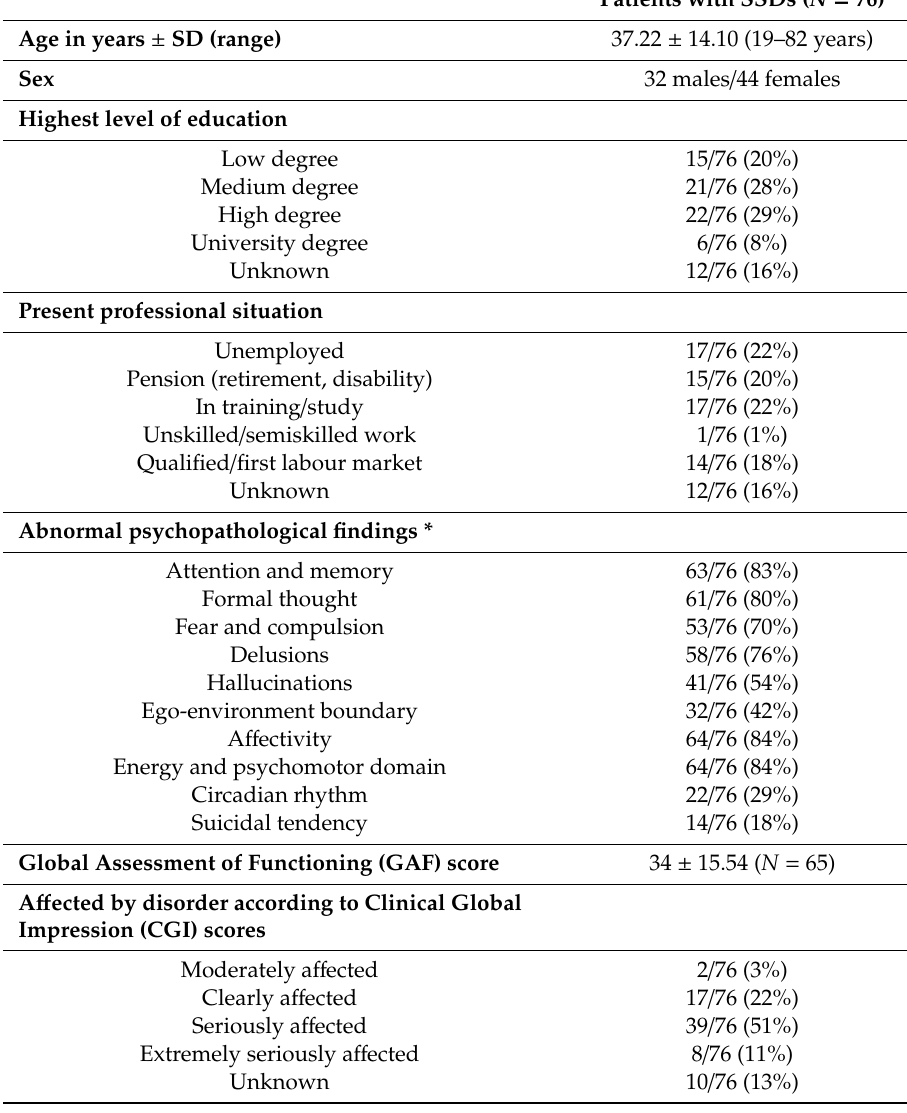
Table 2. Sociodemographic and psychopathological findings in patients with schizophrenia spectrum disorders (SSDs). * Following the criteria of the German “Arbeitsgemeinschaft für Methodik und Dokumentation in der Psychiatrie“